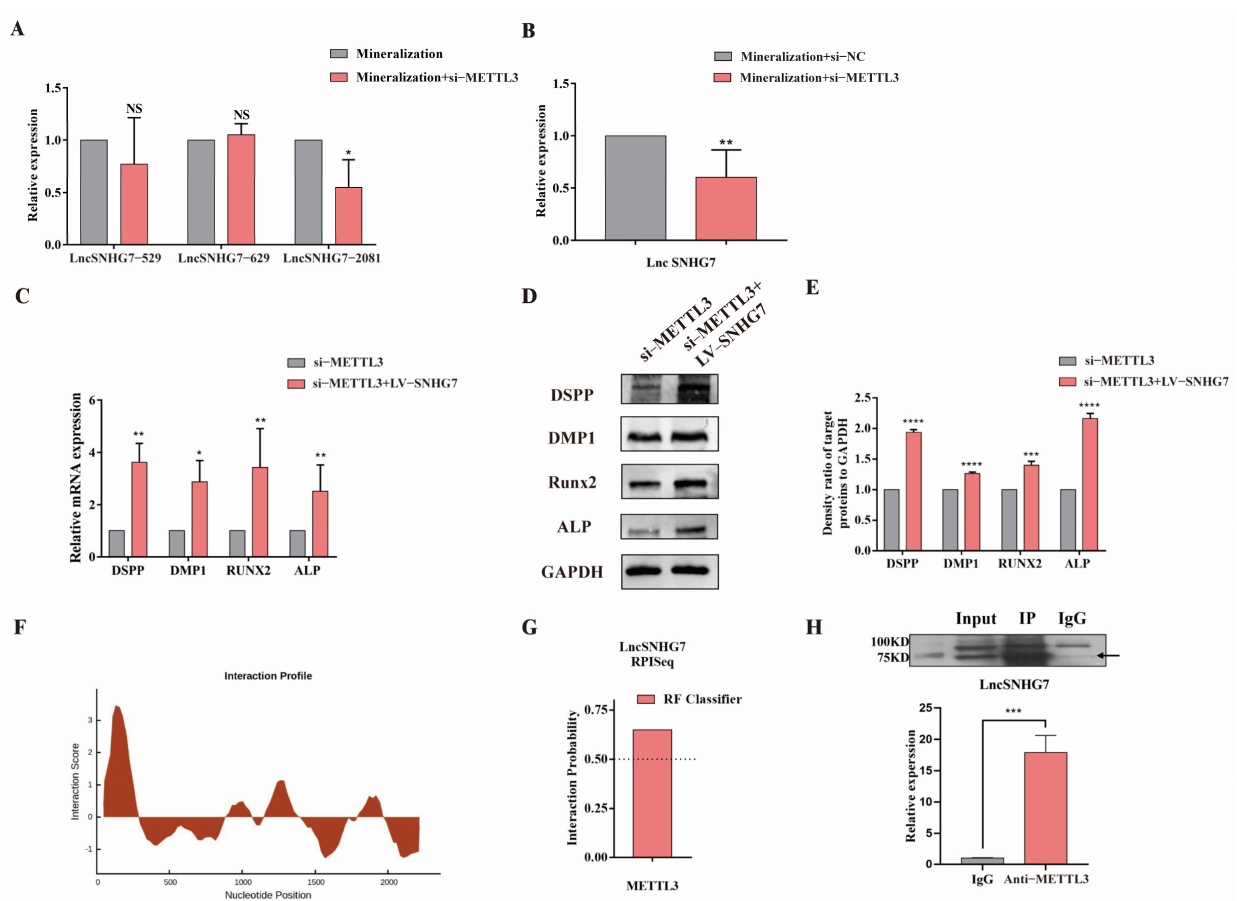
Figure 6. METTL3 regulated the m 6 A modification of lncSNHG7. ( A ) Single base site PCR (MazF) analysis was used to confirm the m 6 A modification site of lncSNHG7 after the knockdown of METTL3. ( B ) The expression level of lncSNHG7 after the knockdown of METTL3. ( C , D ) The mRNA and protein expression of osteogenic/ odontogenic genes (DSPP, DMP1, RUNX2 and ALP) under METTL3 knockdown and co-transfection of LV-lncSNHG7. ( E ) The density ratio of target proteins to GAPDH. ( F ) The binding sites between METTL3 and lncSNHG7 were predicted online. ( G ) RPISeq assay showed that METTL3 could bind to lncSNHG7 (The value greater than 0.50 indicates high binding possibility). ( H ) RIP-qPCR confirmed the interaction between METTL3 and lncSNHG7. The data were represented as means ± SD for each group: * p < 0.05, ** p < 0.01, *** p < 0.001, **** p < 0.0001. NS: Not Statistically